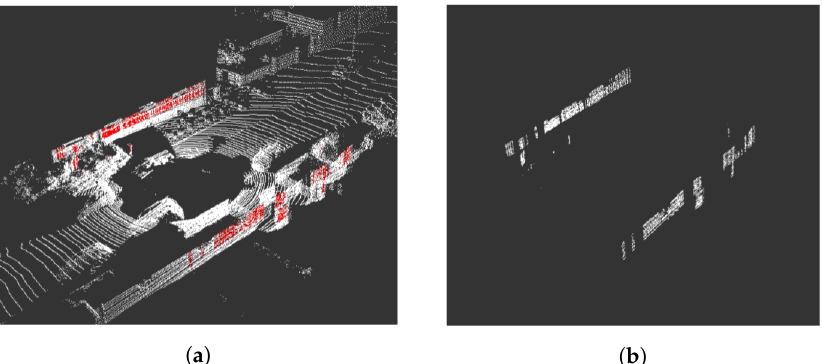
Figure 10. Intermediate results of sequence 00, frame 482: ( a ) Input cloud to the plane detection algorithm; and ( b ) points detected on candidate planes.